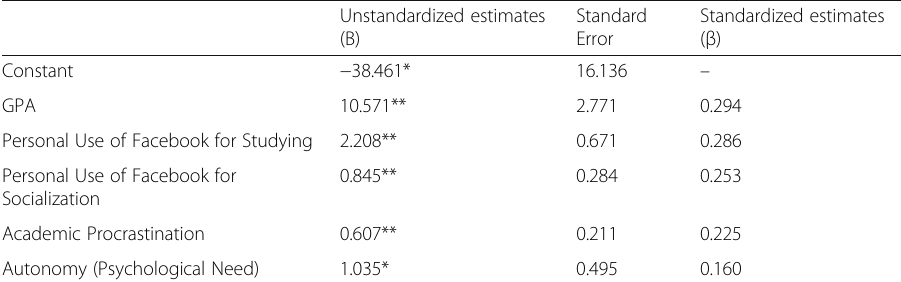
Table 3 Coefficients of remained variables on facebook educational